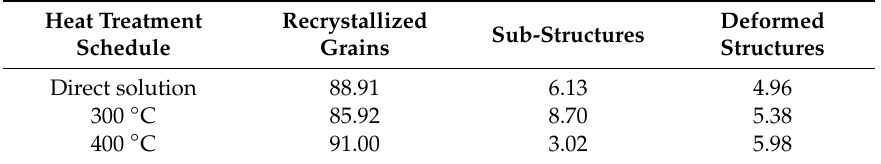
Figure 7. EBSD images showing the structure distribution of the solutionized samples after annealing at different temperature. ( a ) Direct solution; ( b ) 300 °C; and ( c ) 400 °C. Table 4. The recrystallization fraction of the solutionized samples after annealing treatments at di ff erent temperatures